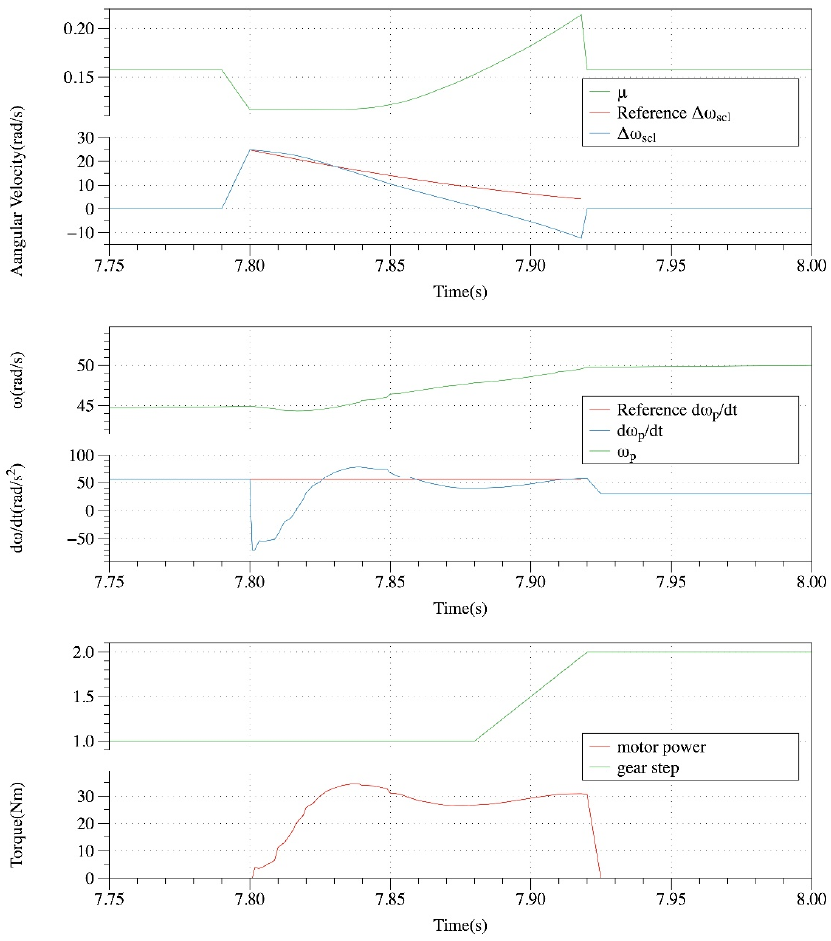
θ = 2 ◦ and change of µ well estimated. Figure 16. The shifting performance with 2    and change of  well estimated. Figure 16. The shifting performance with Appl. Sci. 2020 , 10 , x FOR PEER REVIEW 23 of 26